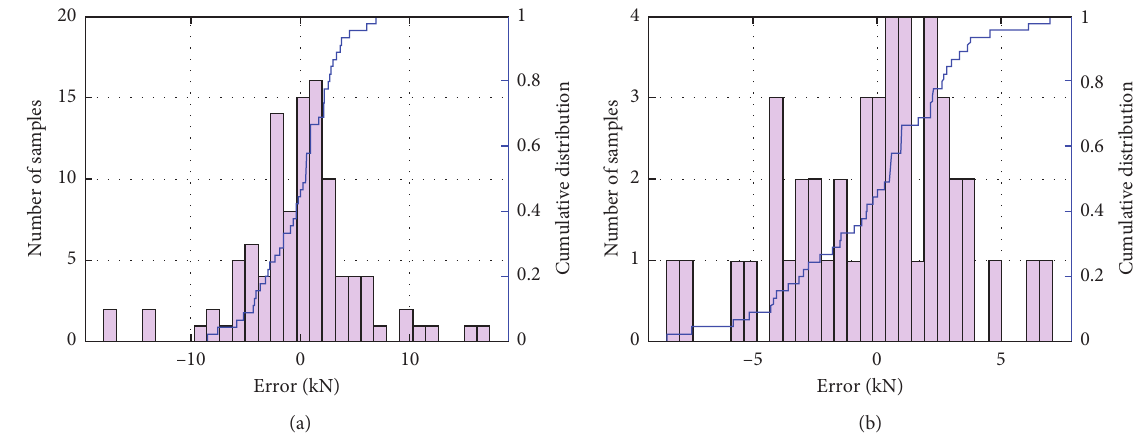
Figure 9: Experimental and predicted load-carrying capacity in function of the sample index for the training and testing datasets.